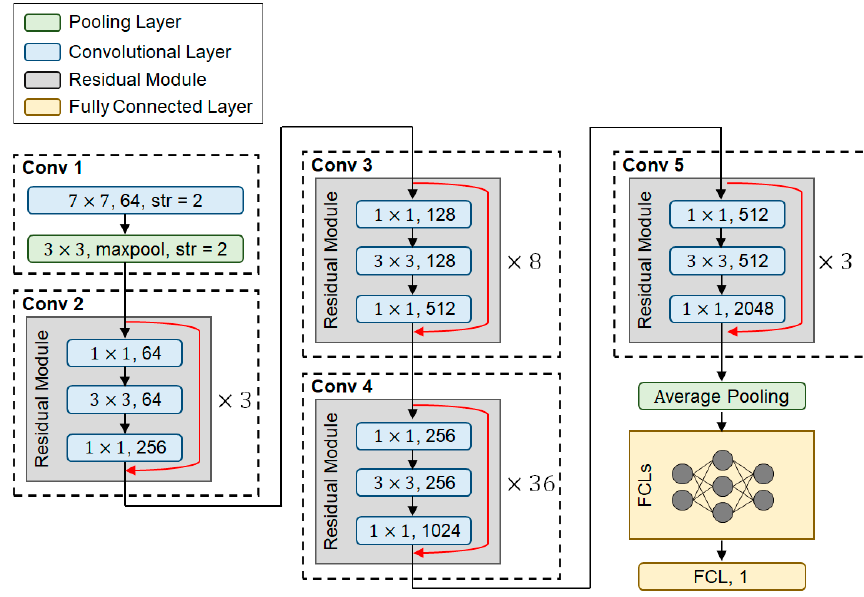
Figure 1. Developed DNN structure using transfer learning with ResNet152. Structure of DNN RN152 is shown in Figure 1. In Figure 1, green, blue, grey, and orange boxes denote the pooling layer, convolutional layer, residual module, and fully connected layer, respectively. Red lines indicate shortcut structures for residual learning. DNN RN152 has two individual stages to process the images: feature extractor and classifier. From